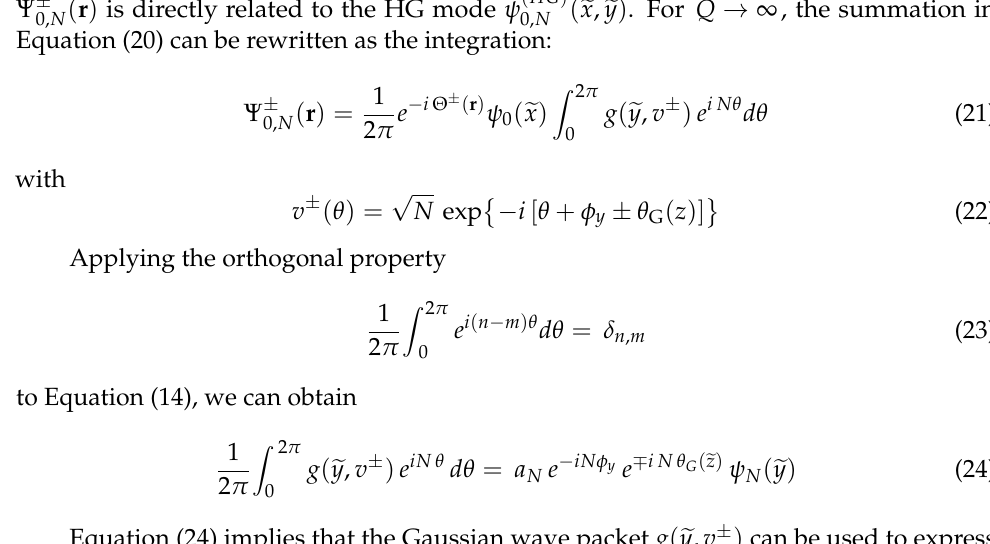
Figure 6. Calculated patterns for 2 for N = 6.